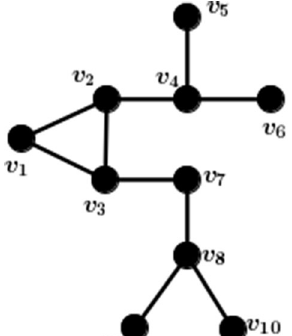
Fig. 1 Illustration of graphs with prunable nodes